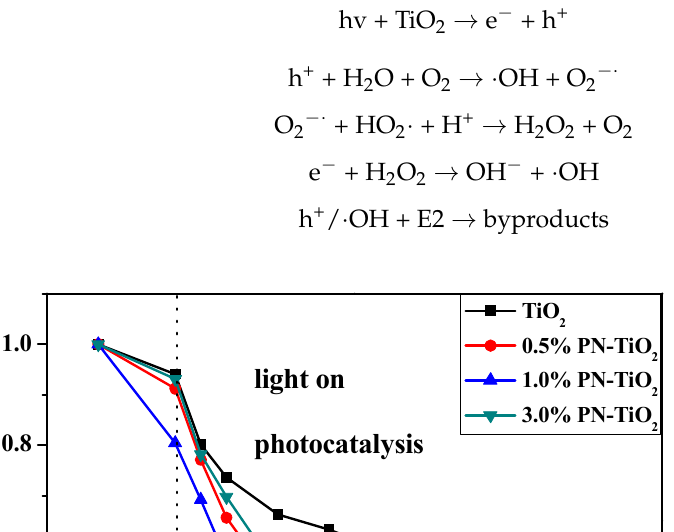
7 of 14 Figure 6. SEM images: ( a ) SEM spectrum, ( b ) EDS of PN-TiO 2 composite, ( c ) overlapping of P, Ti, and C elements, ( d – f ) elemental maps of 3% PN-TiO 2 . 2.2. Photodegradation Performance of PN-TiO 2 2.2.1. Effects of Different Levels of PN Content To investigate the photocatalytic efficiency of composites with different levels of PN content, 0.05 g of TiO 2 , 0.50% PN-TiO 2 , 1% PN-TiO 2 , and 3.00% PN-TiO 2 were individually mixed with 500 mL of 10 ppm E2 solution for comparative study (Figure 7). As Figure 7 indicates, the removal of E2 was significantly improved with an increase in PN content. In addition, bare TiO 2 was observed to be more hydrophilic, leading to the lower adsorp- tion of E2 on the surface of the catalyst. However, it is observed that the photodegradation of E2 was enhanced for 0.5% PN, but a further increase in the PN content decreased deg- radation performance. This may be attributed to the fact that PN as an electron acceptor may prevent electron-hole recombination caused by TiO 2 [31–35]. Moreover, h + may react